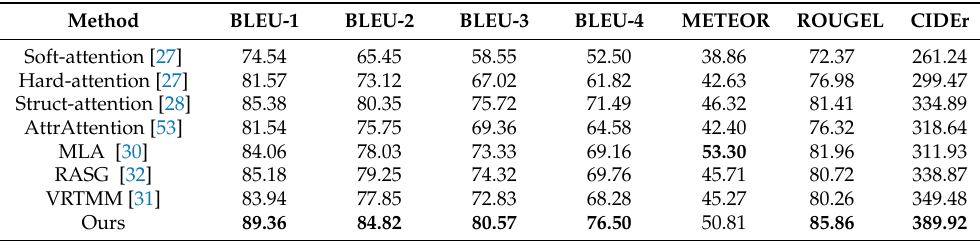
Table 1. Comparison scores (%) on UCM data